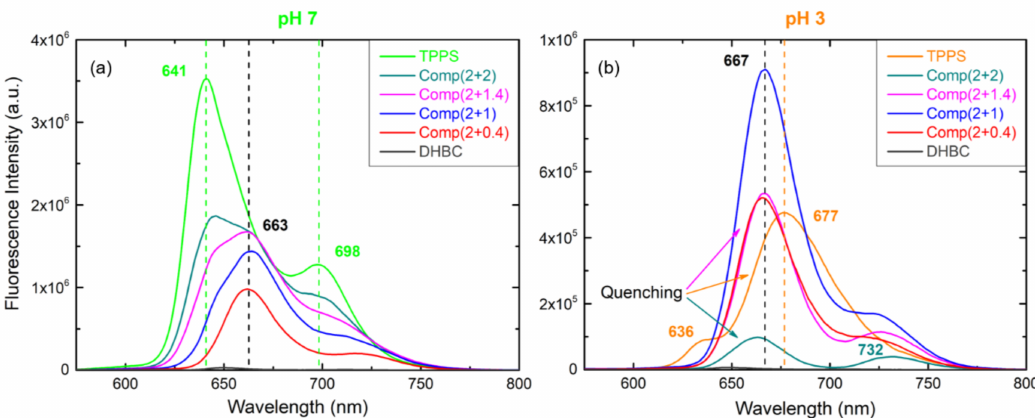
Figure 5. Fluorescence spectra of the DHBC/TPPS complex solutions at pH ( a ) 7 and ( b ) 3. The corresponding spectra of neat TPPS and DHBC are also included for